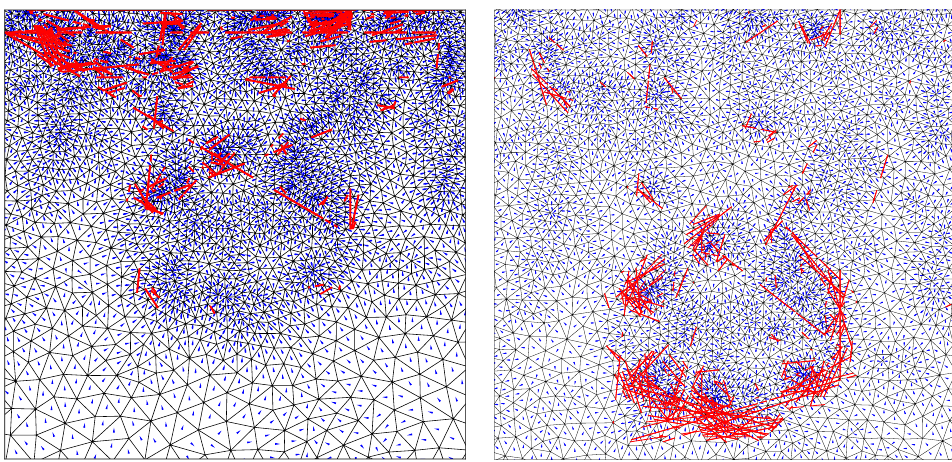
Figure 36 . The same as figure 33, but for the example with exponentially increasing background considered in section